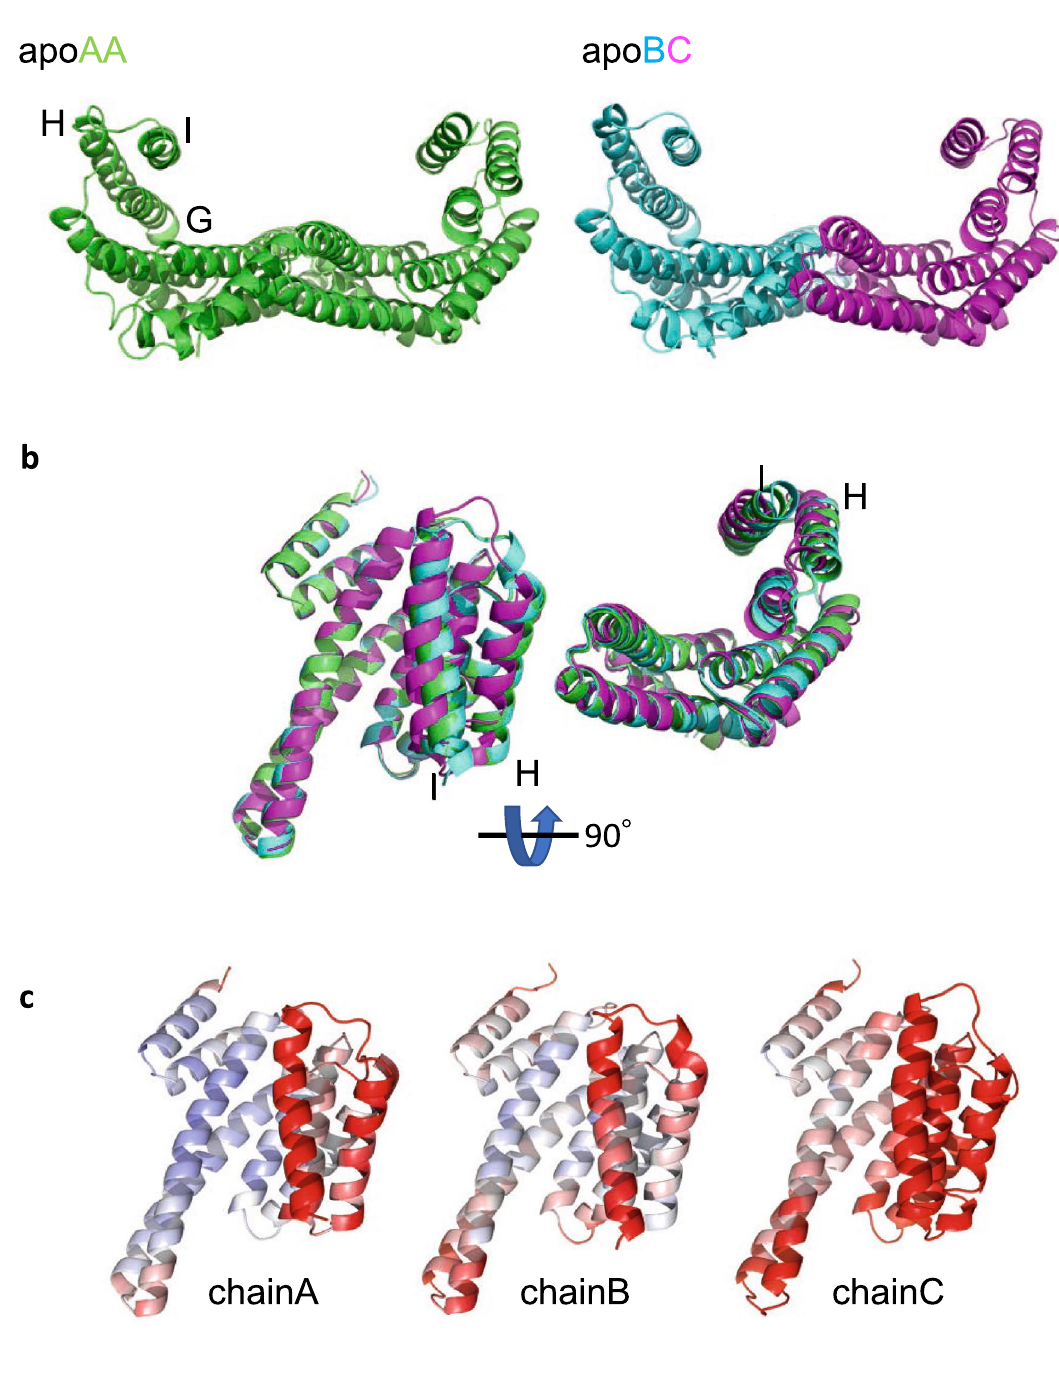
Figure 1. St14f has flexible C-terminal helices H and I. ( a ) Crystal structures of St14f dimers. Three chains (A, B, and C) are involved in the asymmetric unit. Chains A, B, and C are shown as green, cyan, and magenta, respectively. In the crystal, chains AA and BC exist as dimers. The structures of St14f are the same as those of other 14-3-3 proteins, whose monomer consists of nine antiparallel α-helices consisting of a binding site to interact with phospho-serine or threonine motifs. ( b ) Superposed structures of three monomers (chains A, B, and C) of the free St14f form. The N-terminal helices A-G are very similar conformations, and the C-terminal helices H and I show specific conformational differences. ( c ) B-factor of St14f monomers (chains A, B, and C). B-factor coloring is shown as blue-white-red (minimum: 10, maximum: 100). In C-terminal helices H and I, each of the chains showed a high B-factor; in particular, C-terminal helix I showed the largest conformational differences between the three chains. Figures are prepared by PyMol 2.6 (http:// www. pymol. org/ pymol) 42